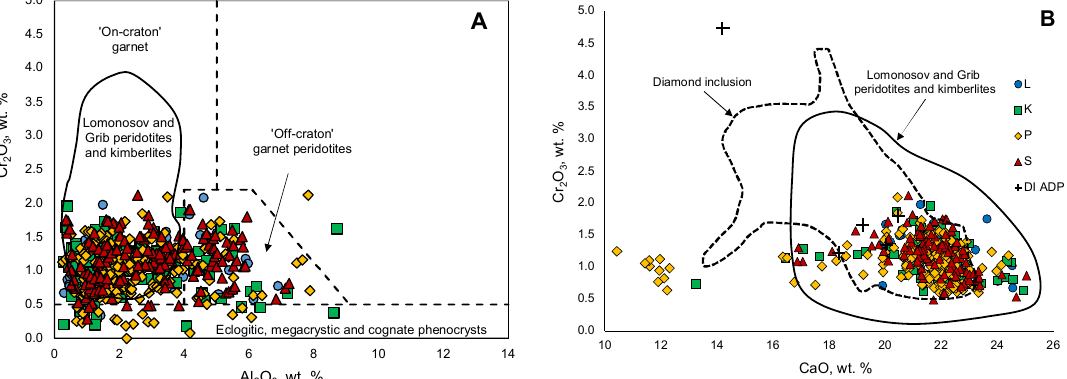
Figure 6. Major element composition of Cr-diopside. ( A ) Cr 2 O 3 –Al 2 O 3 diagram [38]; ( B ) Cr 2 O 3 –CaO diagram. Lomonosov and Grib kimberlites and peridotites [11,35,37–39], diamond inclusion field [44], DI (inclusion in diamonds) from the ADP [11].